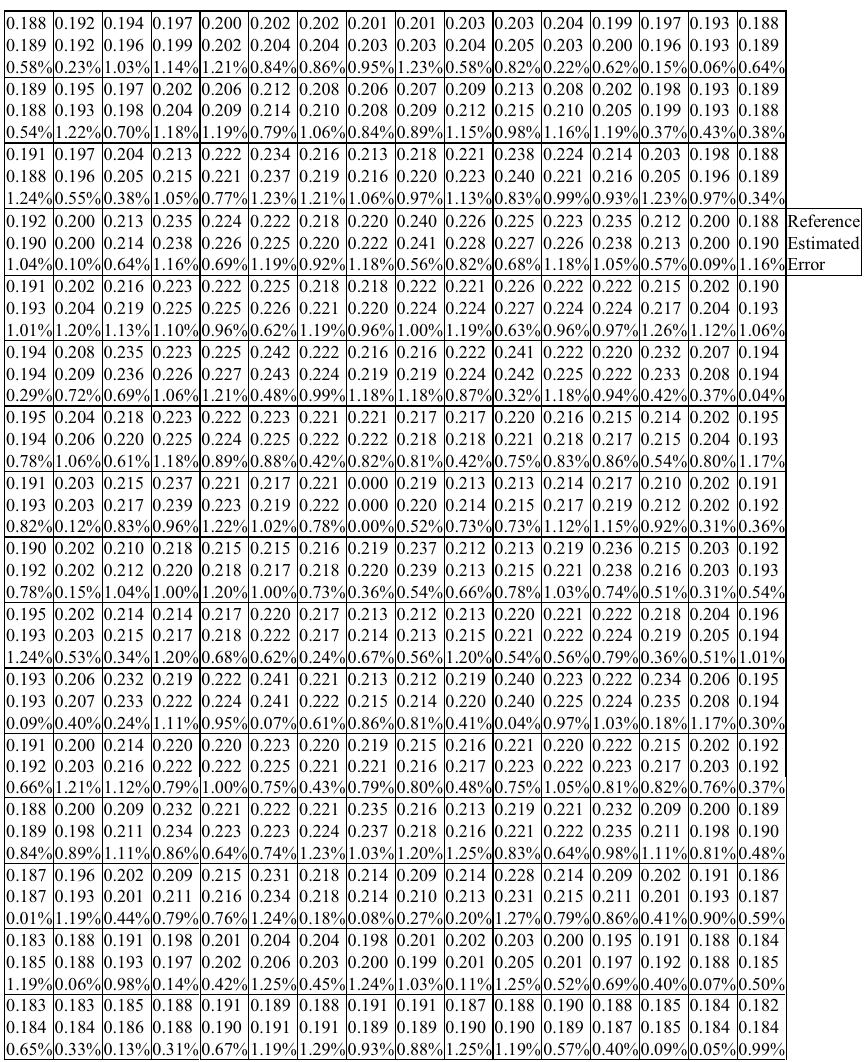
Fig. 6. Comparing the reference to estimated fl uxes by the algorithm, for each pin of the fi rst layer of assembly